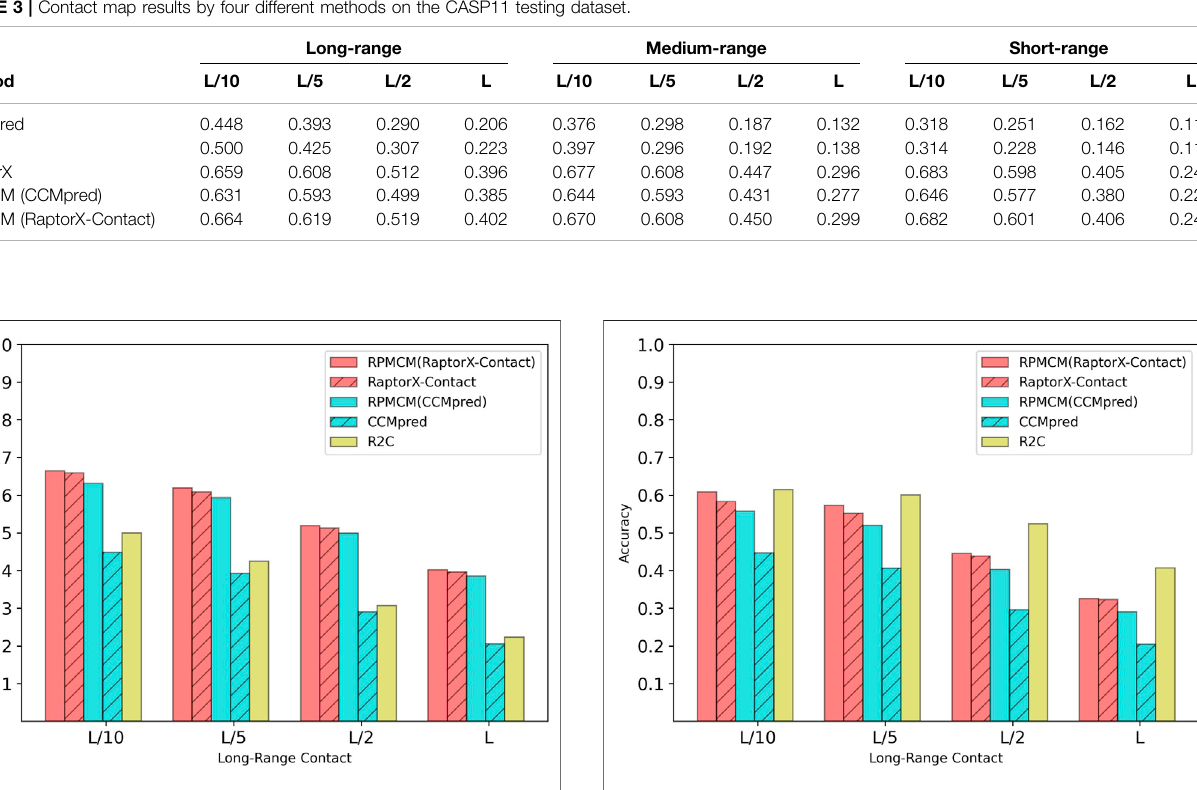
FIGURE 6| Comparison of method accuracy for the long-range contact on the CASP12 testing